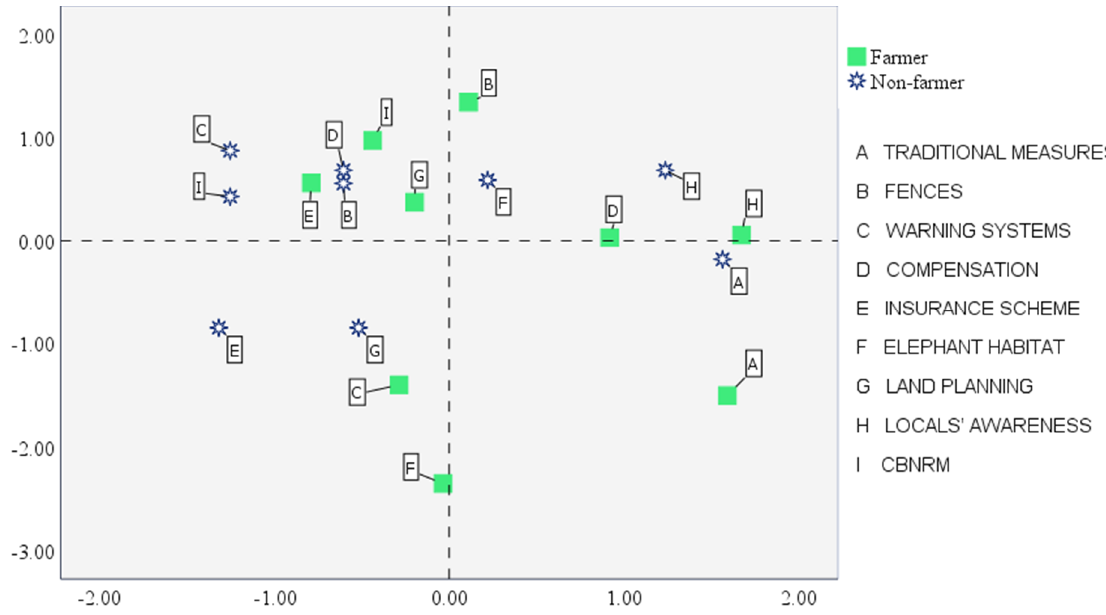
Figure 3. Differences between farmer and non-farmer overall perceptions of HEC management approaches.